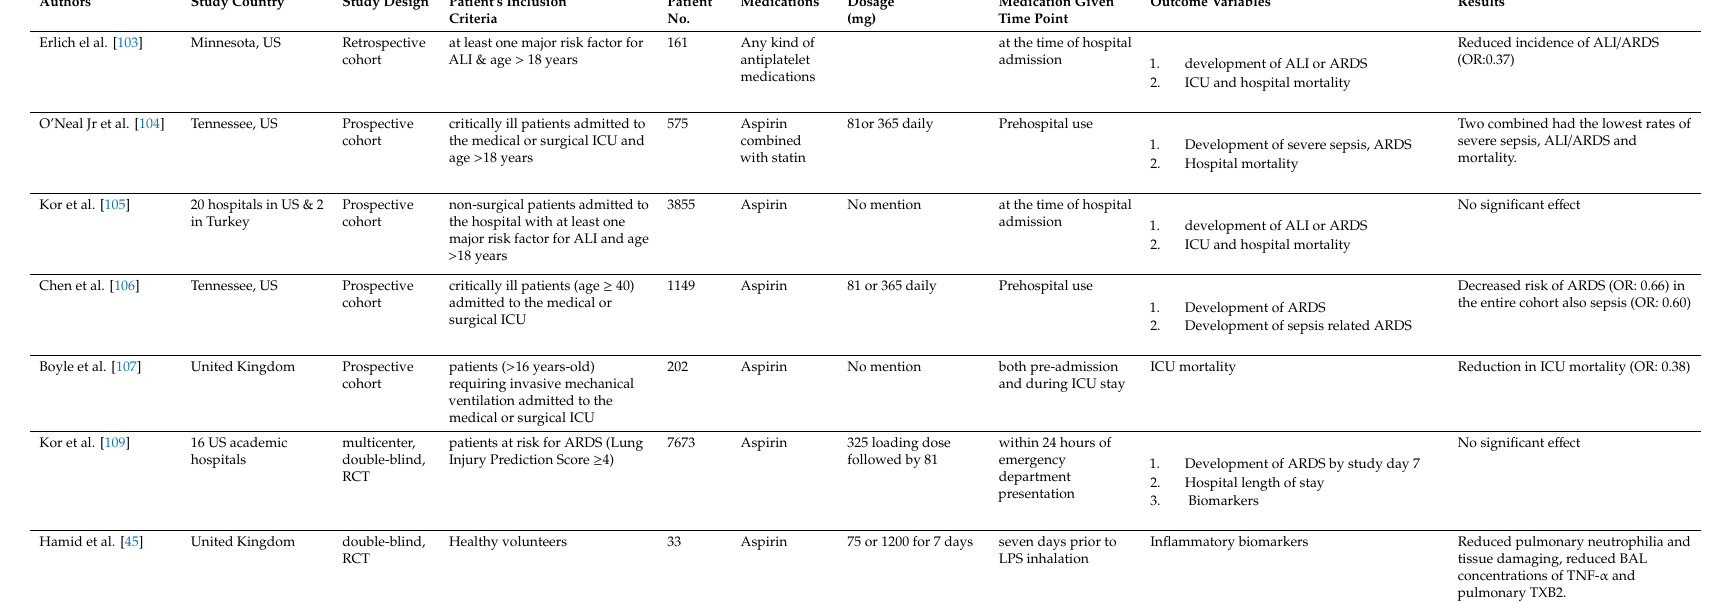
Table 1. A summary of recent cohort studies into antiplatelet therapy for